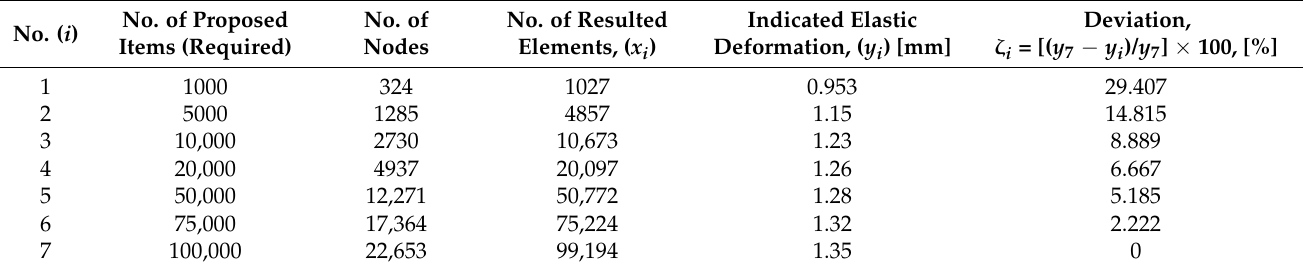
Table 8. Values obtained at FEA study at compression, bending and torsion of a pole with double arm in the console.